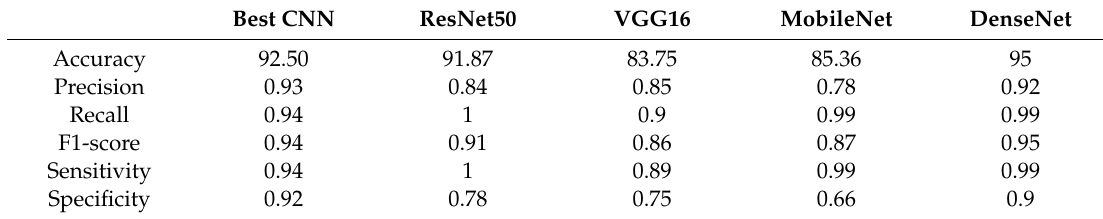
Table 12. Malignant disease class performance comparison of di ff erent methods.